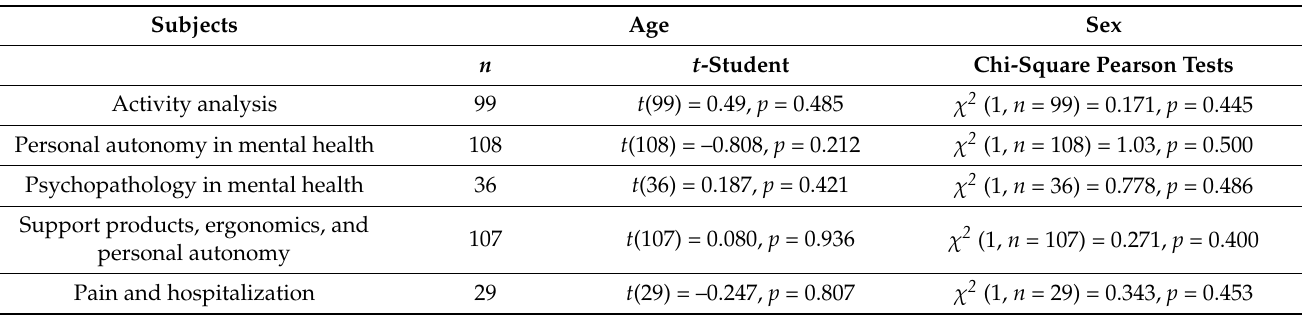
Table 1. Preliminary analysis: analysis of differences in age and sex between the groups without and with MOOC in 5 subjects of the Degree in Occupational Therapy and Physical